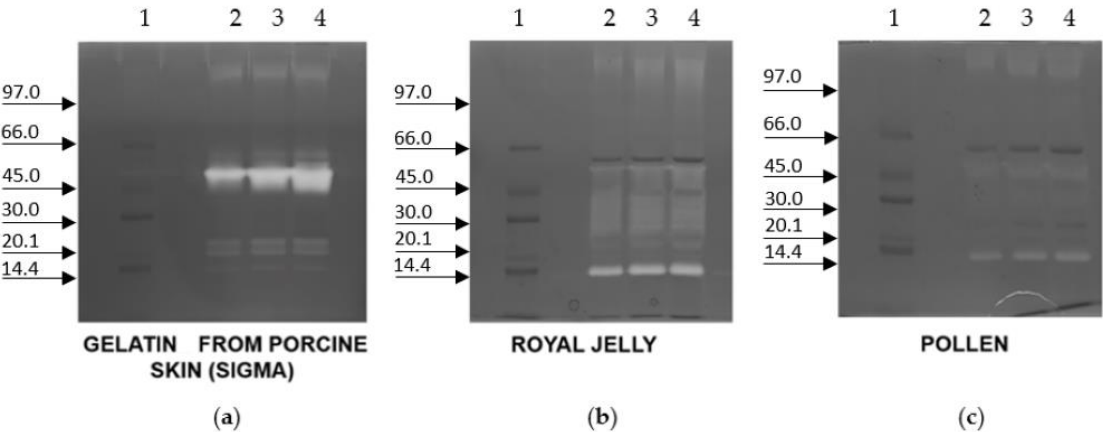
Figure 4. Zymography of the 5th-instar worker-fate larvae crude extract with precast gels containing 0.1% ( w / v ) of different substrates: ( a ) gelatine from porcine skin; ( b ) royal jelly; or ( c ) pollen (10% T, 2.6% C). Lane 1, marker low range in kDa; lanes 2 – 4, different quantities, 10, 15, and 20 µg, of proteins of worker-fate larvae crude extract were loaded in each gel.